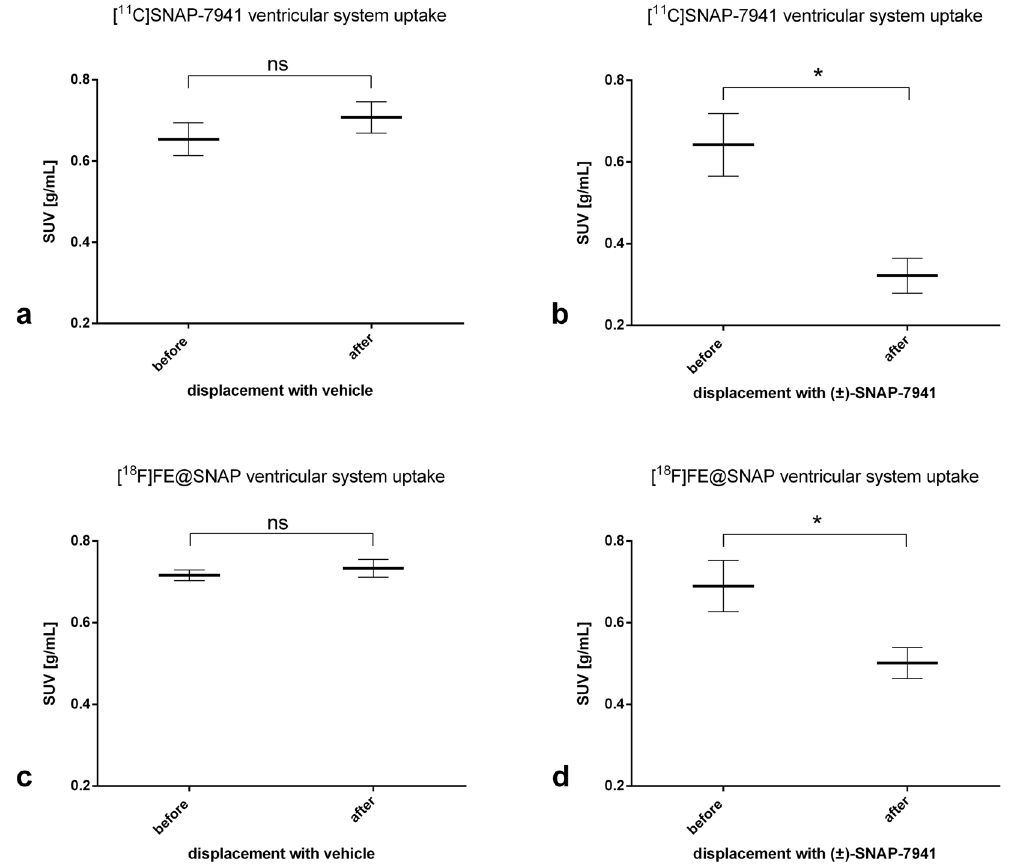
Figure 5. Radiotracer uptake in the ventricular system. Radiotracer uptake in the ventricular system of [ 11 C] SNAP-7941 before and after displacement with either vehicle ( a ) or 15 mg/kg ( ± )-SNAP-7941 (b) and [ 18 F]FE@ SNAP before and after displacement with either vehicle ( c ) or 15 mg/kg ( ± )-SNAP-7941 ( d ). Data are displayed as mean ± SEM from independent experiments (n ≥ 3). Differences among groups were tested using a two-tailed parametric paired t-test (ns = P > 0.05; * P < 0.05). If not visible, error bars are within the margin of the symbols.